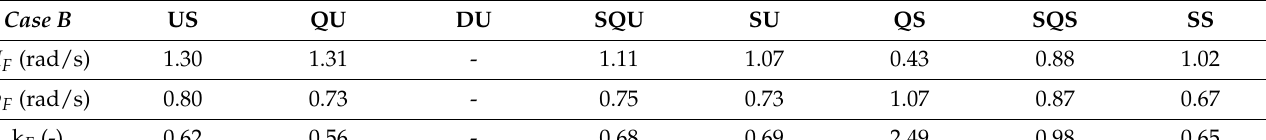
Table 4. Flutter analysis results for Case B using different aerodynamic models.